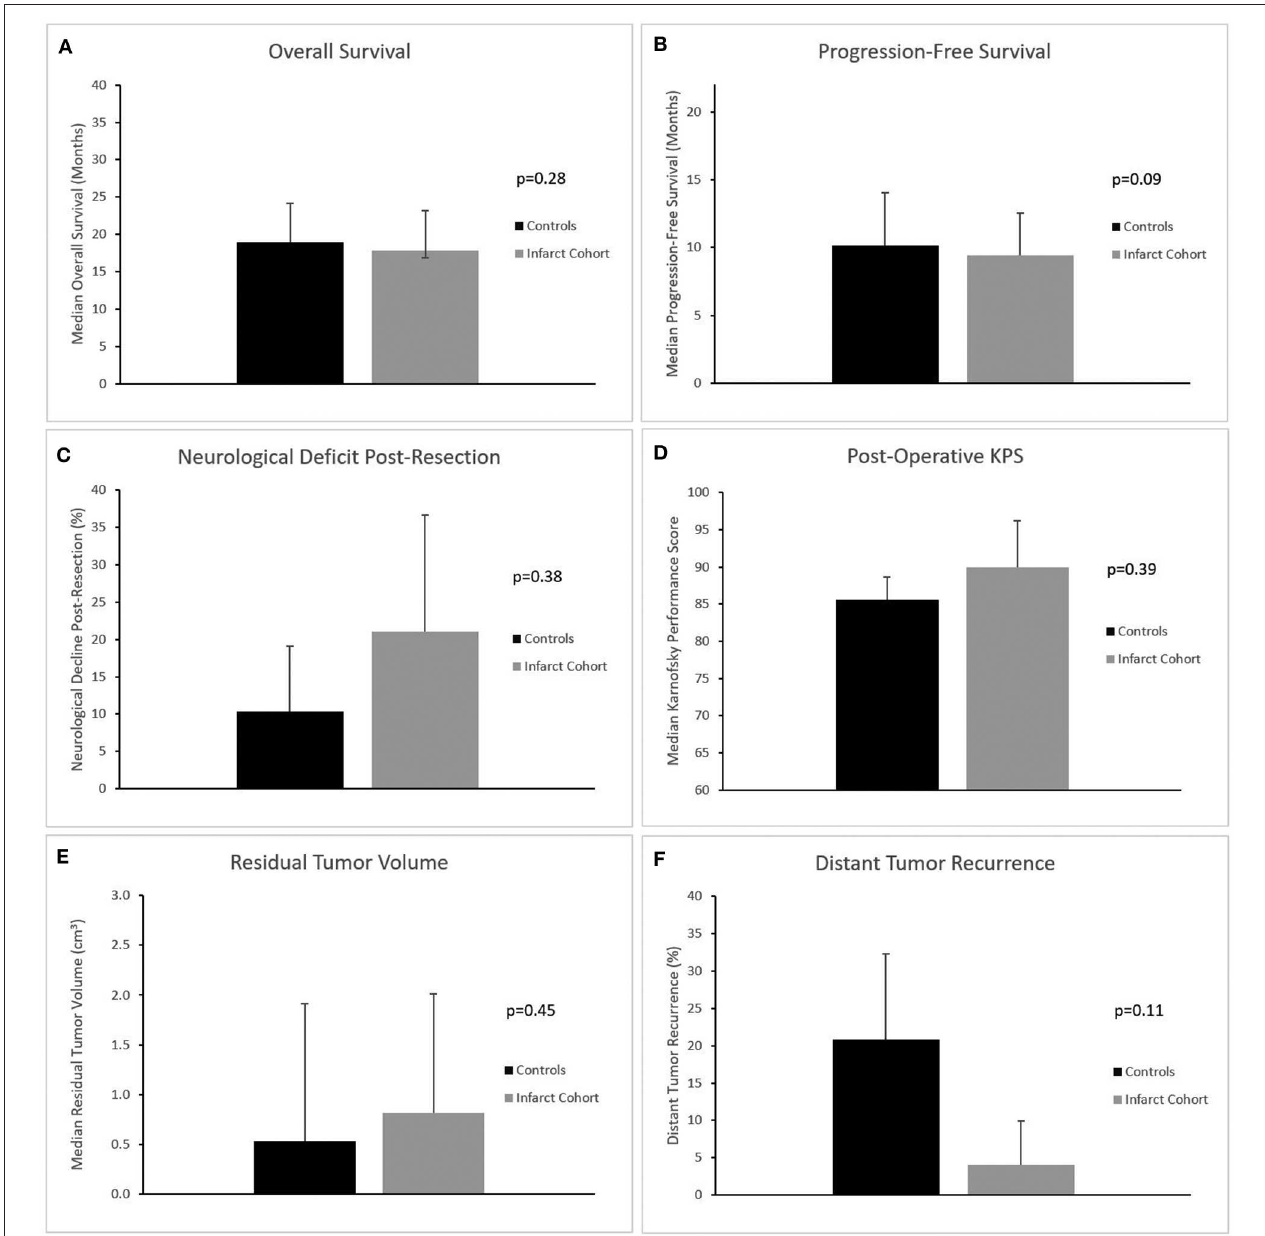
FIGURE 3 | (A–F) Bar graphs comparing overall survival, progression-free survival, rate of neurological deficit, postoperative KPS, residual tumor volume post-resection, and rate of distant tumor recurrence between cohorts. There were no significant differences noted between the two cohorts in any of these variables.